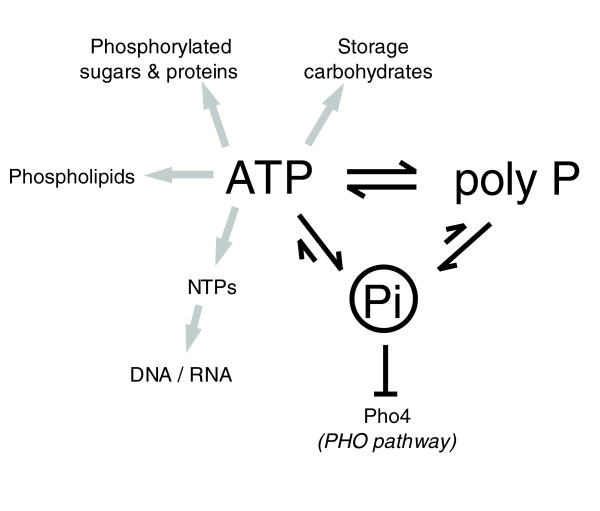
Poly P links energy and phosphate metabolism in a 'phosphate-energy-network'. Enzymatic reactions between the main phosphate/energy pools, ATP and poly P (shown by black arrows) are (at least partly) hypothesized. Flow to different organic phosphate/energy pools is indicated by the gray arrows. In contrast to ATP, poly P is less directly interconnected with the other phosphate pools and, therefore, its levels fluctuate more.